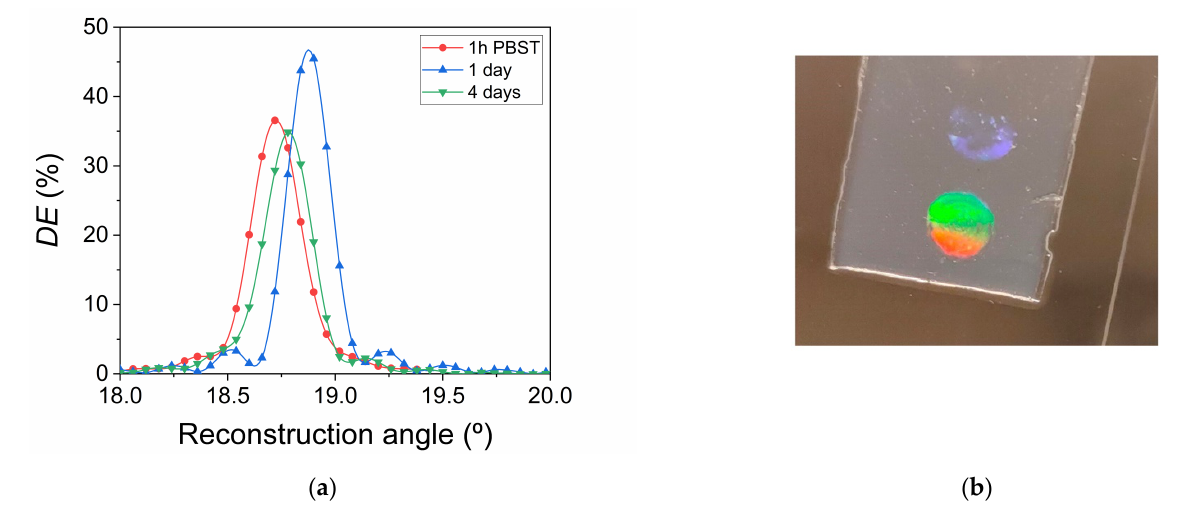
Figure 9. ( a ) DE as a function of the reconstruction angle for a transmission grating reconstructed immediately after being 1 h immersed in PBST solution at ambient conditions (red circles and line), 1 (blue tringles and line) and four days (green triangles and line) immersed in PBST solution and stored at 4 °C. ( b ) Image of the unslanted transmission gratings daylight illuminated.